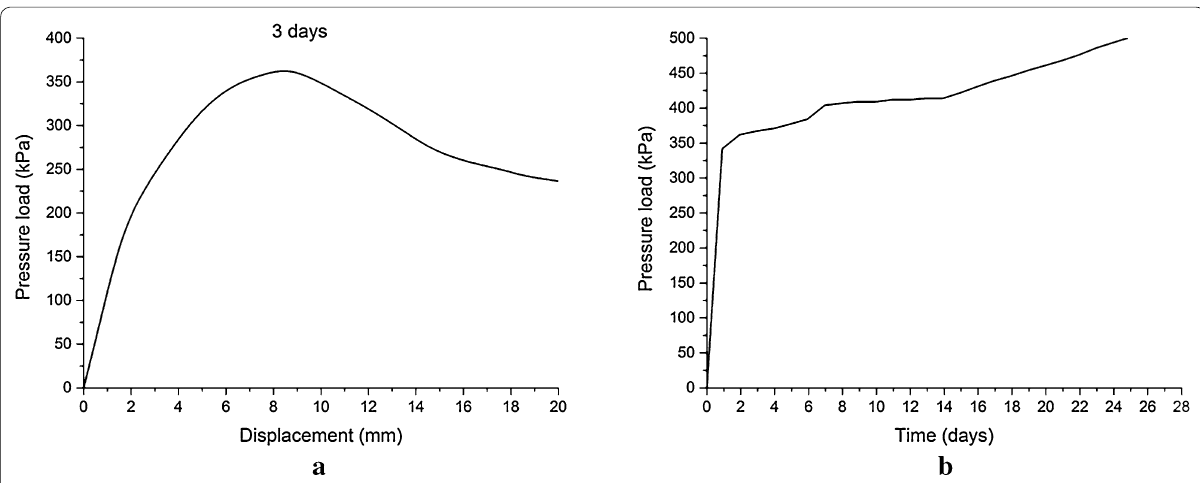
Fig. 14 Cantilevered retaining wall results: a load–displacement curve 3 days after casting and b evolution of the maximum carrying capacity of the